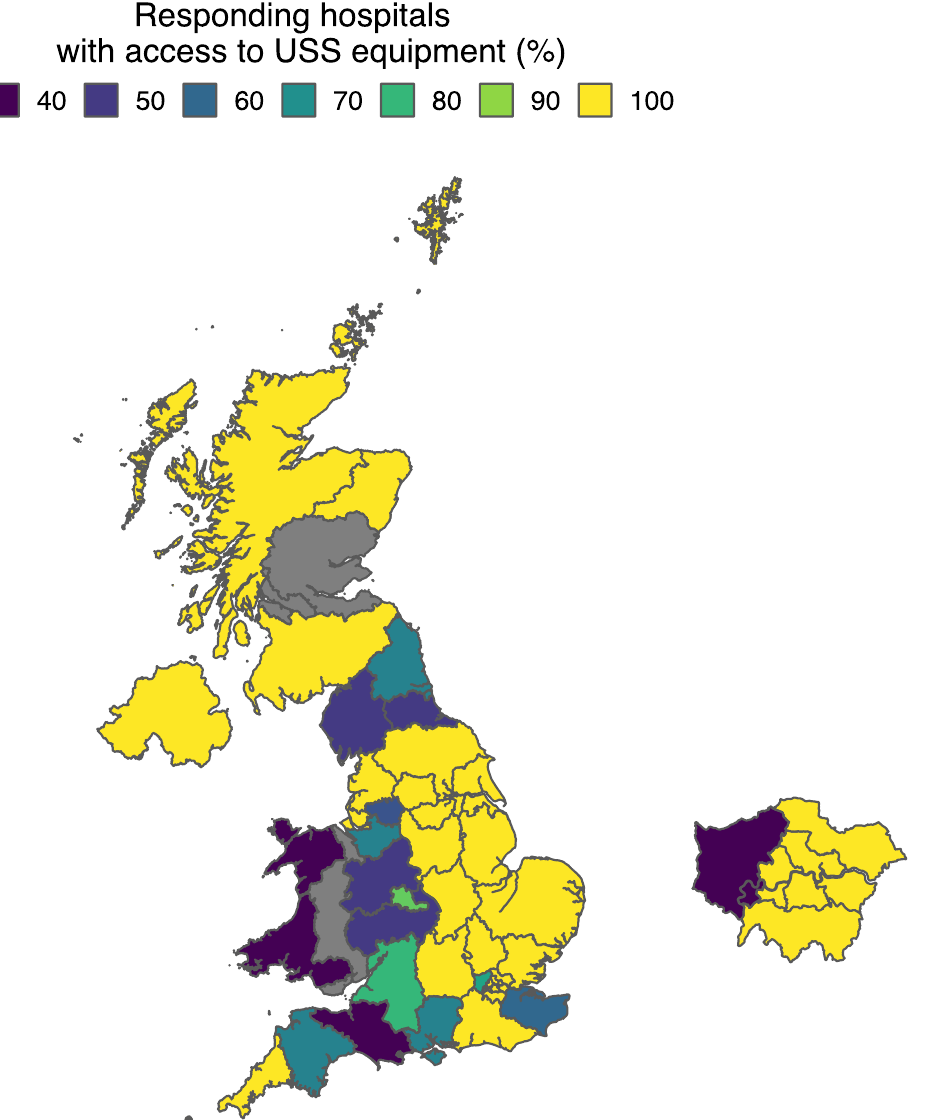
Fig. 2 Geographical variation in access to ultrasound equipment at the regional level amongst SAMBA participating hospitals. *grey responses available to calculate